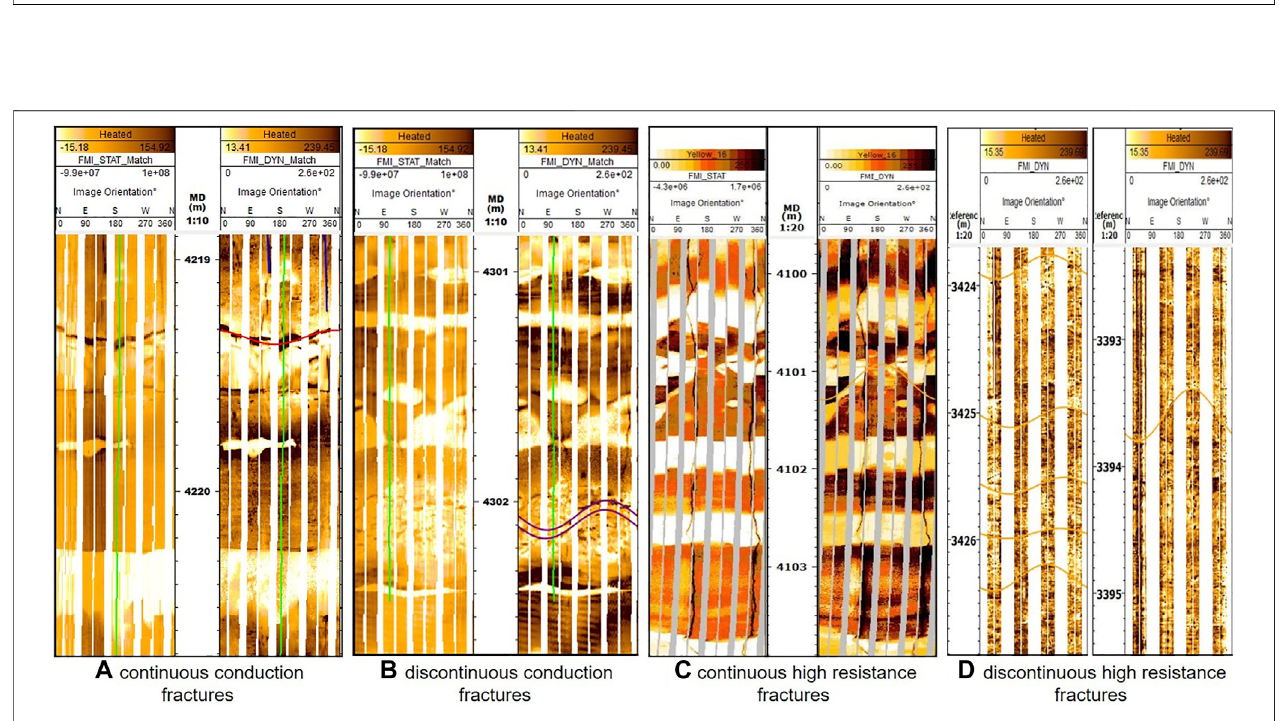
FIGURE 8 | Fractures in the borehole image logs from wells in the LD-A gas fi eld. (A) Continuous conduction fractures in well LD-A-1-13, (B) discontinuous conduction fractures in well LD-A-1-13, (C) continuous high-resistance fractures in well LD-A-1-6, and (D) discontinuous high-resistance fractures in well LD-A-2-1.